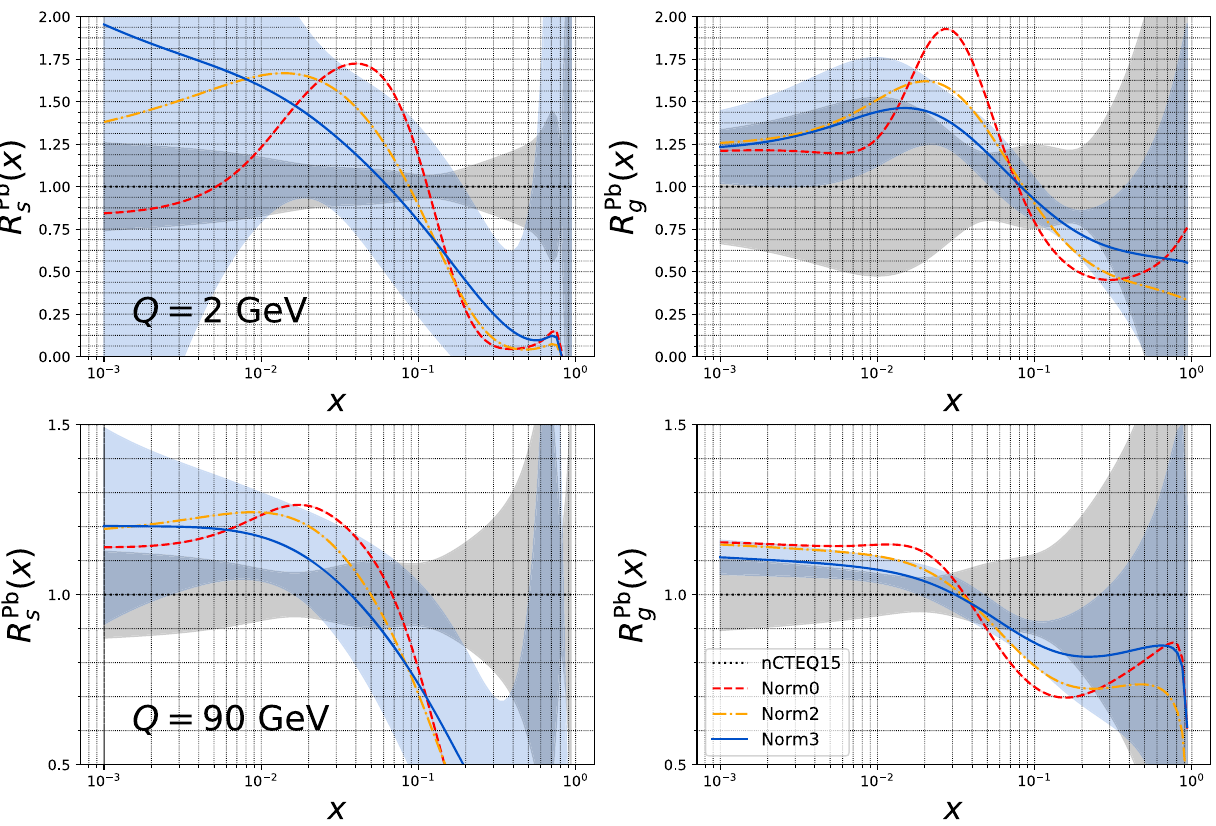
Fig. 10 Ratio of strange and gluon nPDFs compared to the corresponding nCTEQ15 nPDFs for Q = 2 GeV (upper row) and Q = 90 GeV (lower row). The uncertainty band for nCTEQ15 is shown in gray, and for Norm3 in